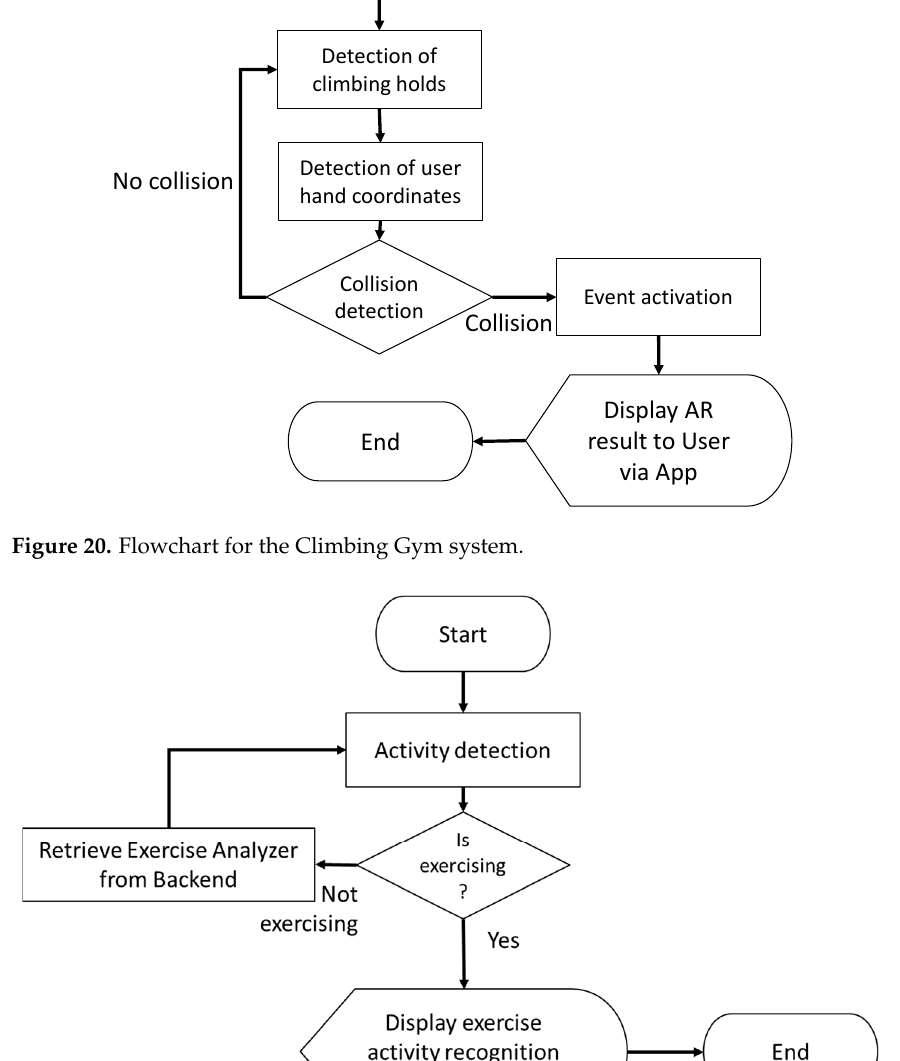
Figure 21. Flowchart of the Jarvis